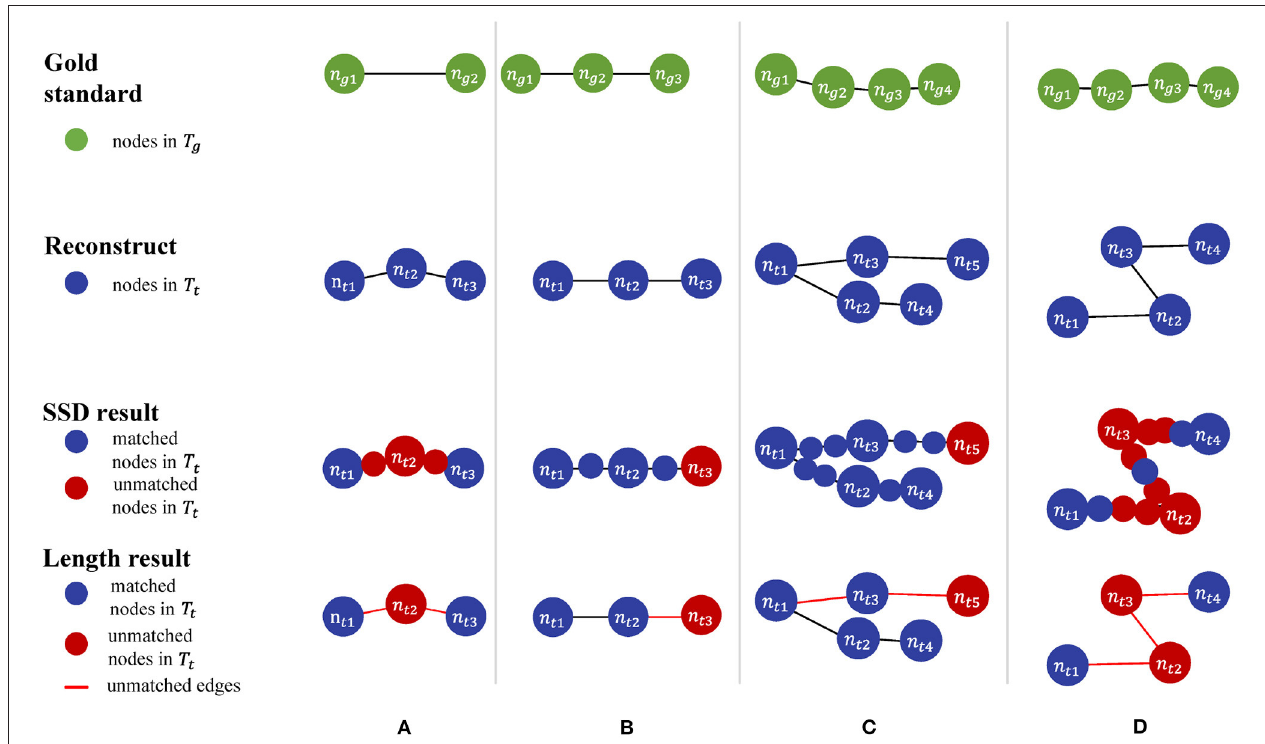
FIGURE 3 | (A–D) Four manually constructed cases for testing geometrical metrics.